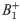
Estimated T1 values as a function of (a) the ME-MP2RAGE and (b) the MP2RAGE signal intensity parameter ρ.The green lines correspond to the effective acquisition parameters while red/blue lighter/darker lines indicate, respectively, ±20% and ±40% offsets of B1+. The flip angle values are adjusted for the accuracy factor ηα. Note that the estimated T1 is limited to an upper value of approximately 3 s for the acquisition parameters that were used for MP2RAGE, which would result in T1 values exceeding this limit (e.g., in CSF) to be underestimated.